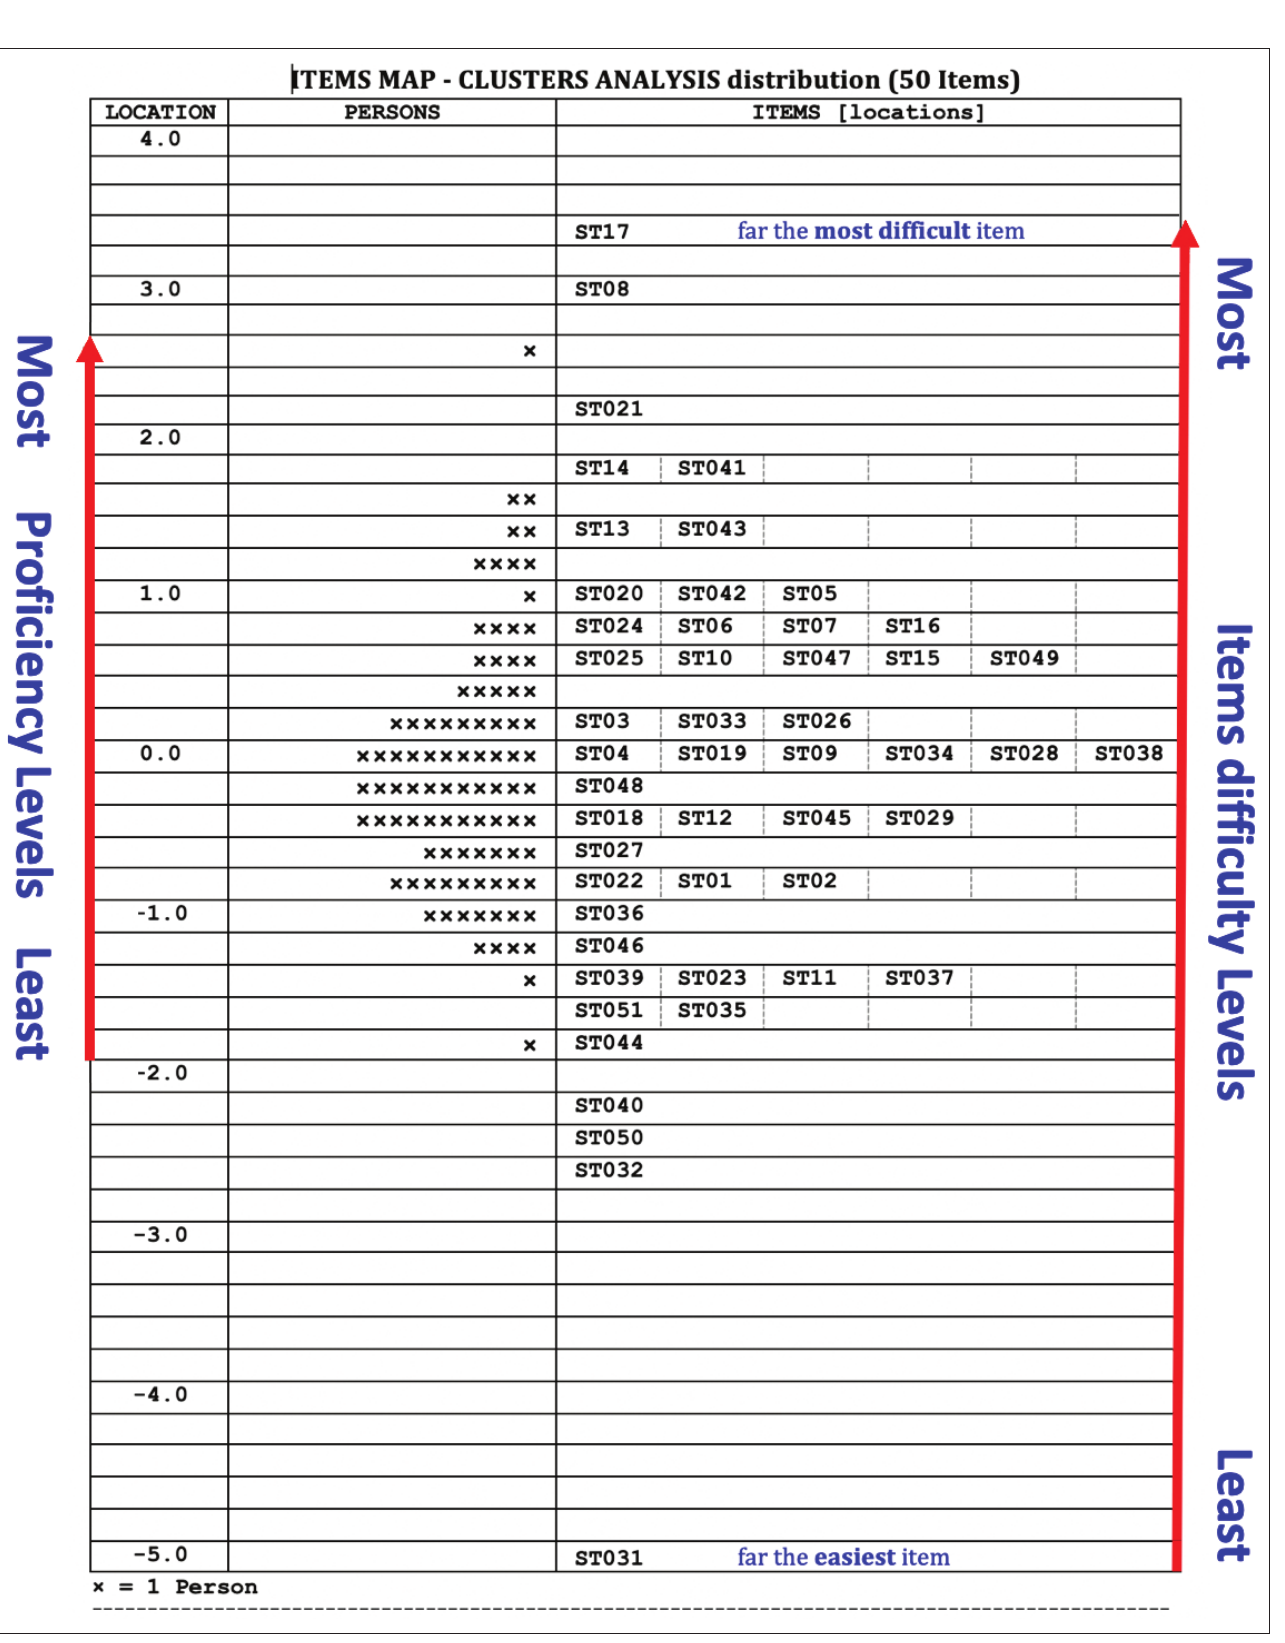
FIGURE 12: Revised person-item